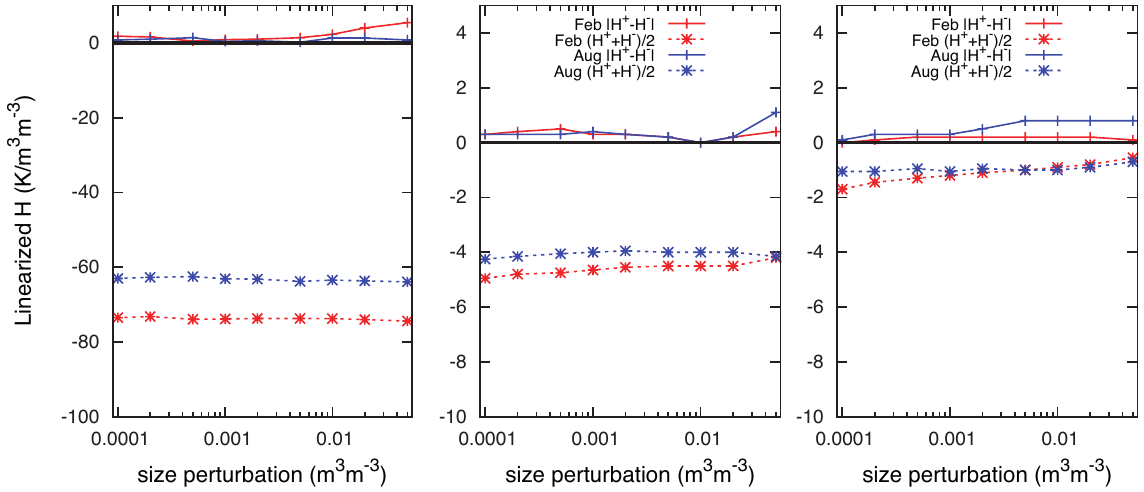
Figure 1. SMOS components of the Jacobians of the observation operator; Global average ( H + + H (cid:0) ) = 2 (dashed line) and absolute difference j H + (cid:0) H (cid:0) j (solid line) for the top 7 cm ( left ), 7–28 cm ( middle ) and 28–100 cm ( right ), calculated with positive ( H + ) and negative ( H (cid:0) ) soil moisture perturbations. The red curve corresponds to the February week experiment, and the dark blue curve for the August week. Note the different vertical scale in the left figure compared to middle and right